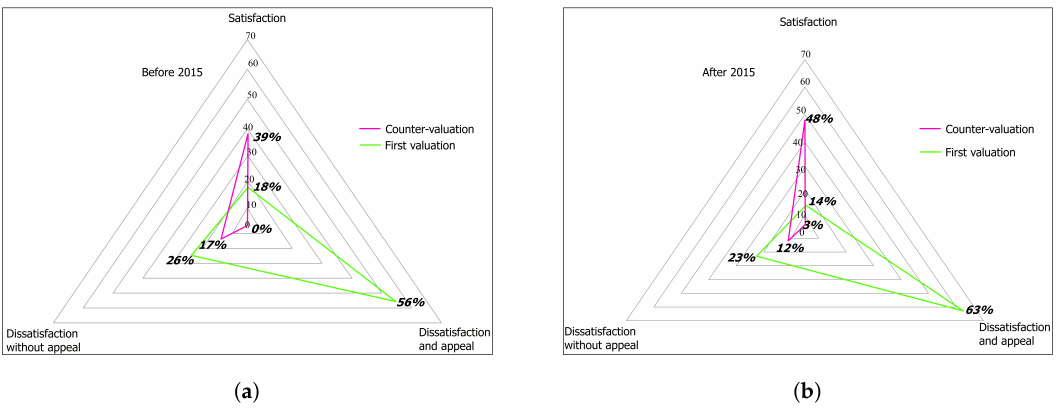
Figure 2. Figure2.This is a figure, Schemes follow the same formatting. If there are multiple panels, Figure 2. ( a ) Trends in satisfaction and dissatisfaction on the compensation before 2015; ( b ) Trends in they should be listed as: ( a ) Description of what is contained in the first panel. ( b ) Description of what satisfaction and dissatisfaction on the compensation after 2015. Data source: Household survey. is contained in the second panel. Figures should be placed in the main text near to the first time they are cited. A caption on a single line should be centered.